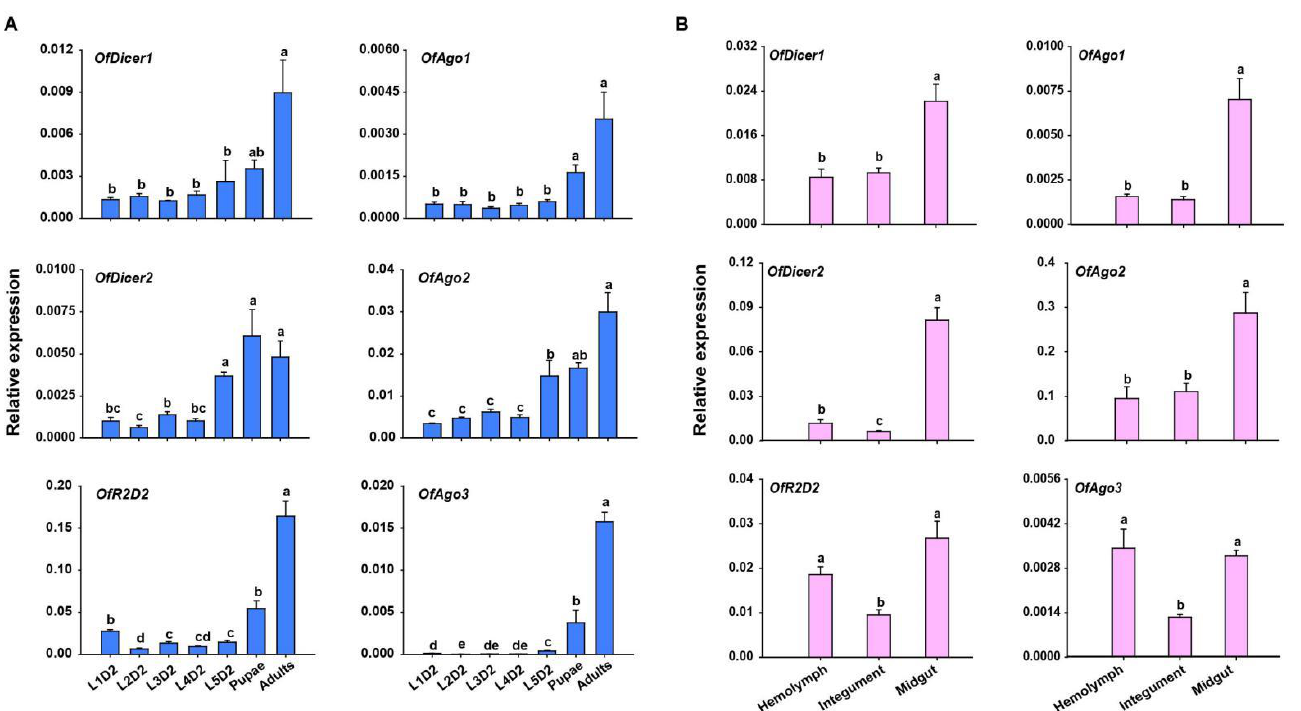
Figure 2. RT-qPCR analyses of relative expression of core RNAi pathway genes in different developmental stages and tissues of O. furnacalis . ( A ) Relative expression of Dicer1 , Dicer2 , Ago1 , Ago2 , Ago3, and R2D2 at different developmental stages of O. furnacalis . L1D2-L5D2: Two-day-old first instar larvae to two-day-old fifth instar larvae. ( B ) Relative expression of Dicer1 , Dicer2 , Ago1 , Ago2 , Ago3, and R2D2 in different tissues including hemolymph (HE), integument (IN), and midgut (MG) in two-day-old fifth-instar larvae. Statistical significance was determined using a one-way ANOVA followed by Tukey ’ s post hoc test. Different letters (a – e) above the bars represent significant differences (n = 5) ( p < 0.05).